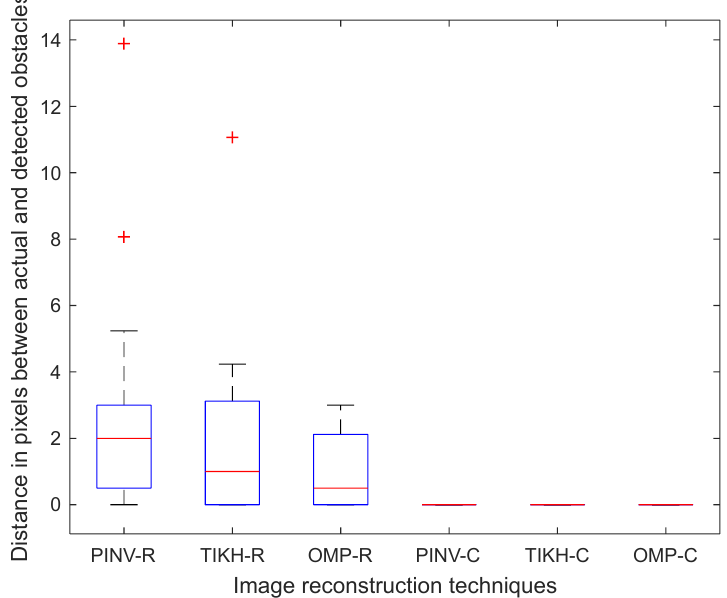
Figure 18. Euclidean distance in pixels between two reconstructed obstacle coordinates and their actual coordinates in the